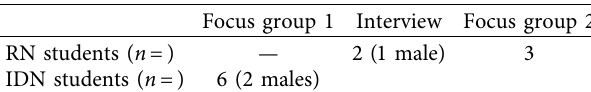
Table 2: The three